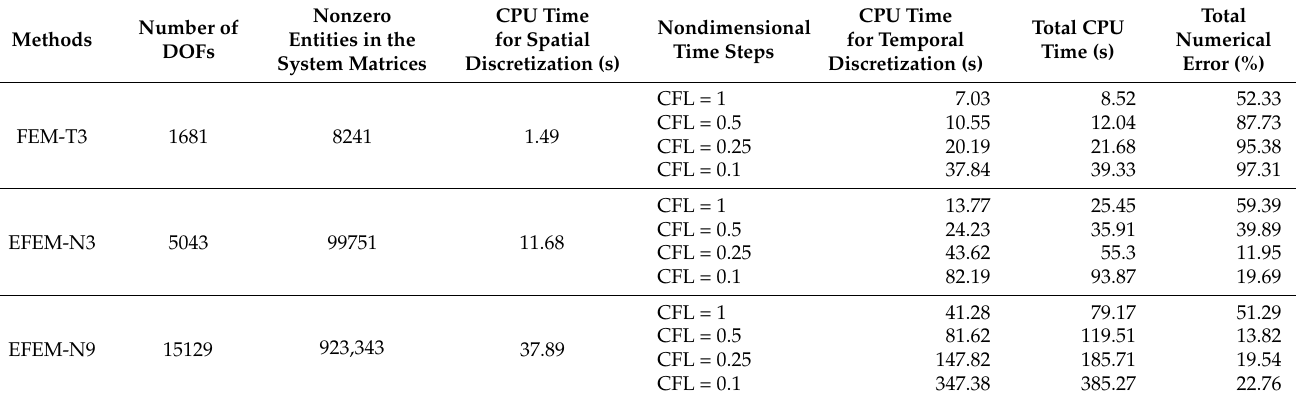
Table 2. Comparisons of the computational cost and computational efficiency of different numerical approaches in solving the scalar wave propagation in a square pre-stressed